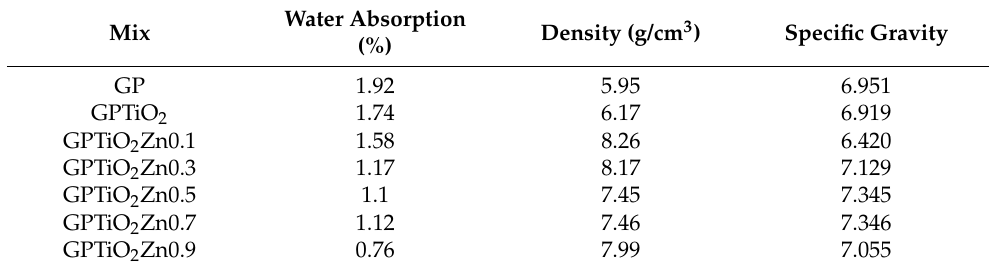
Table 2. Water absorption and density analysis of metakoalin geopolymer coating at S/L ratio